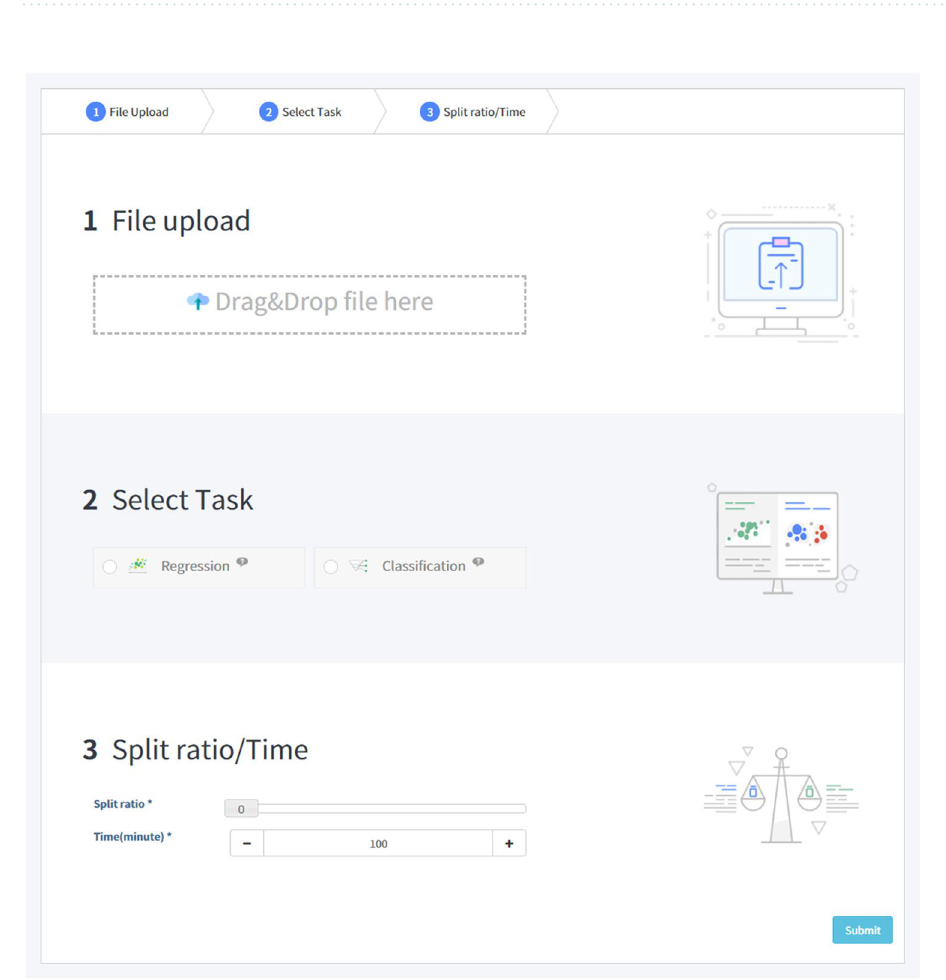
Figure 4. Job submission page of the fine-tuning service. Users upload their own dataset and select the type of task. There is no specific parameter selection for